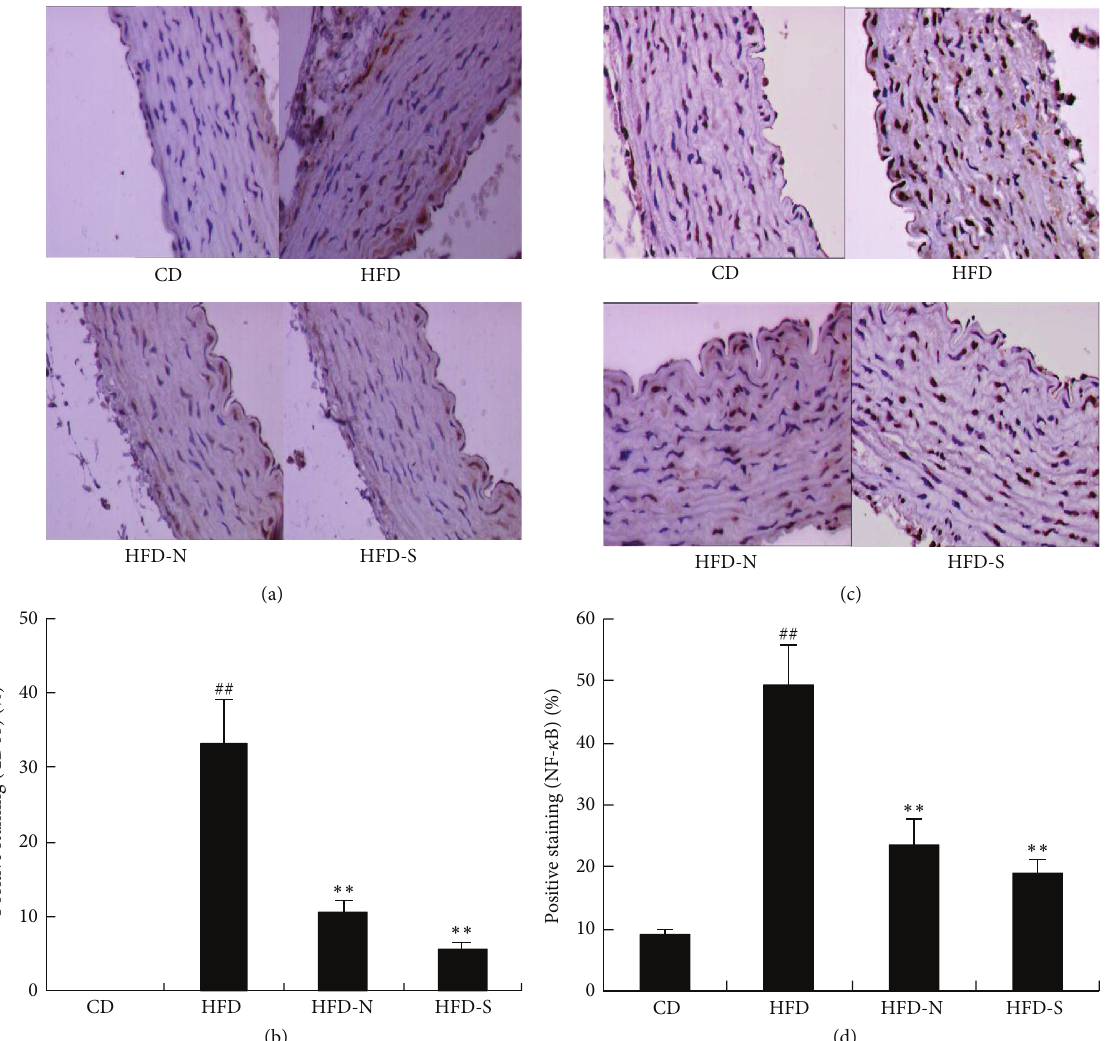
Figure1:NiacinandsimvastatinreducedtheexpressionsofCD68andNF- 𝜅 Bp65inthearterialwallofguineapigsbyimmunohistochemistry analysis after treatment for 8 weeks. (a) and (c) show the representative immunostained aortic sections of CD68 and NF- 𝜅 B p65, respectively (20x magnification; blue = nuclei and brown = target protein). (b) and (d) show the relative levels of CD68 and NF- 𝜅 B positive cells of per view field by densitometric quantitation, respectively. Data are presented as mean ± SD ( 𝑛 = 8 ). ## 𝑃 < 0.01 versus CD group; ∗∗ 𝑃 < 0.01 versus HFD